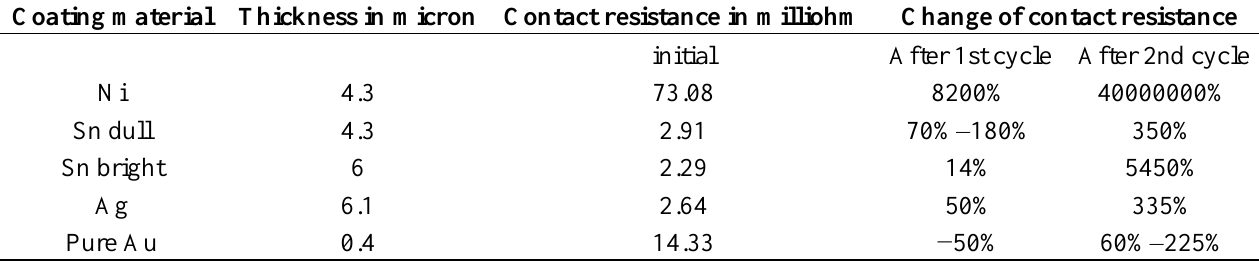
Table 2. Corrosion resistance and change of contact resistance of different coating materials, contacts separated during the test